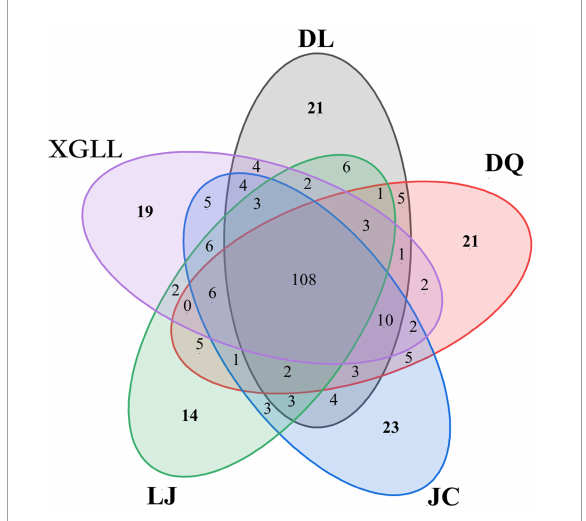
FIGURE5 Venn diagram of fecal microbials of Eothenomys miletus in different